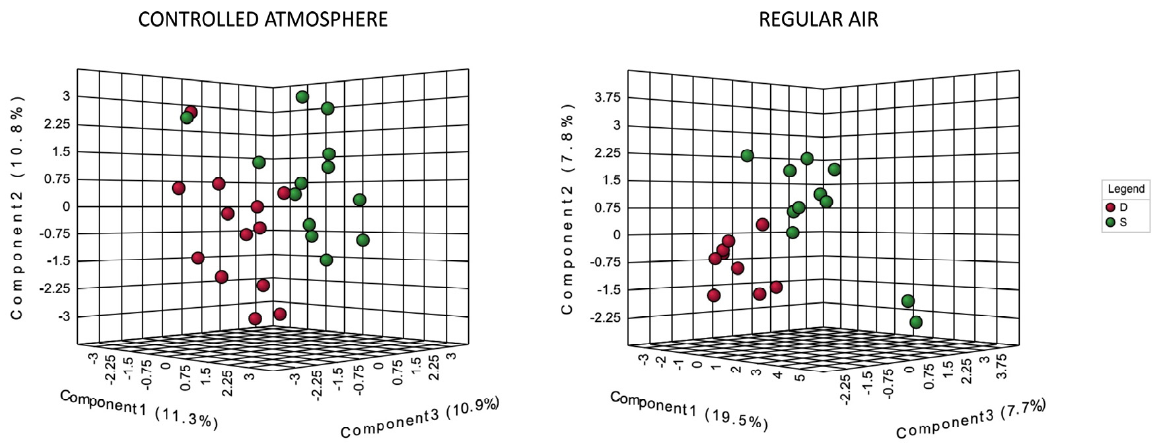
Figure 5. Partial Least Squares Discriminant Analysis (PLS − DA) score plot showing the first three components for the two storage conditions: regular air (RA, at 5 ◦ C) and controlled atmosphere (CA, 4 kPa O 2 and 6 kPa CO 2 at 5 ◦ C). The colored circles represent the rootstocks evaluated, “Duke 7” and “Mexicola”.